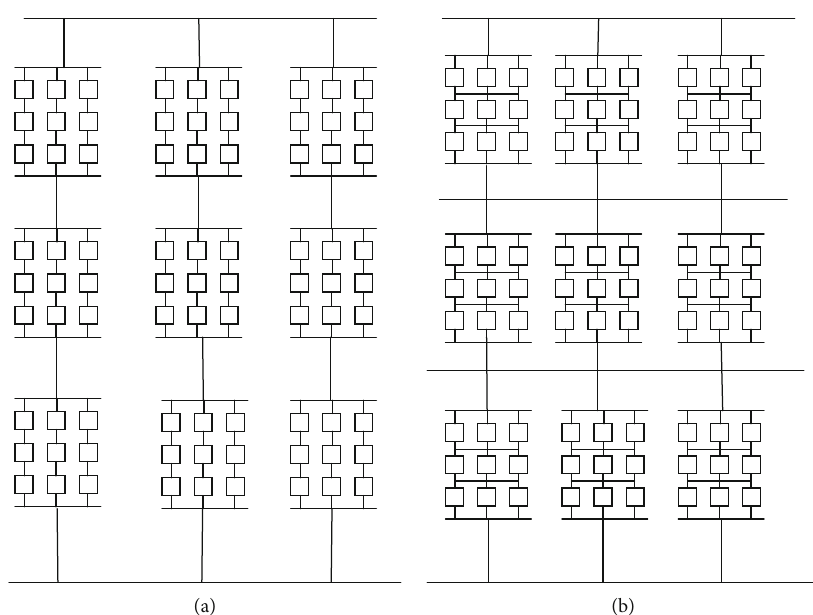
Figure 2: Large-scale PV arrays having subarrays with various interconnections: (a) SP array with SP subarrays and (b) TCT array with TCT subarrays